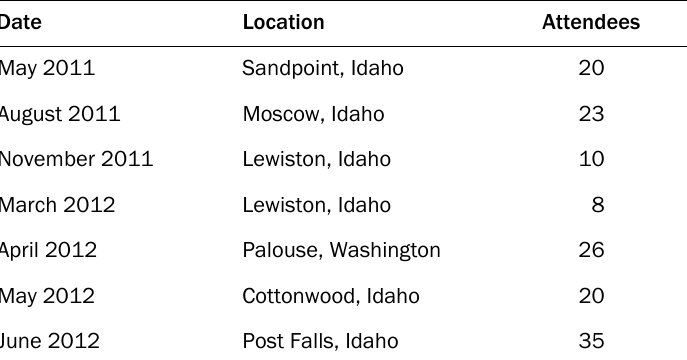
Table 1. Stakeholder Forum Dates, Locations, and